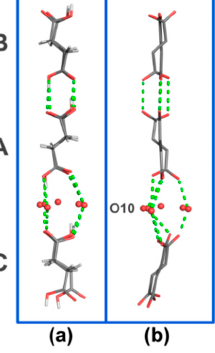
Figure 4. H-bonded motif formed by SA molecules in the asymmetric unit viewed ( a ) along the a -axis and ( b ) along the b -axis. O–O contacts are represented by dashed green lines. H-atoms (in b), α -CD and water molecules have been omitted for clarity. SA molecules are contained in the cavities of the crystallographically-independent CD molecules named A, B and C, see main text for details.